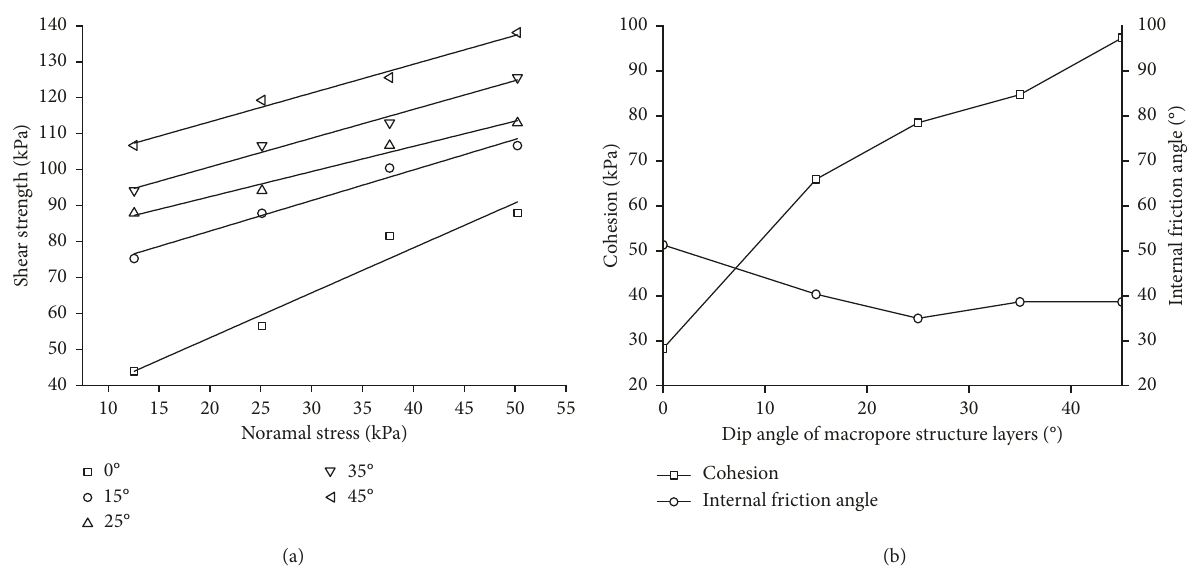
Figure 15: Shear strength of SRMCM in different angles of macropore structure. (a) Fitting curves of different angle. (b) Relationship between strength parameters and different dip